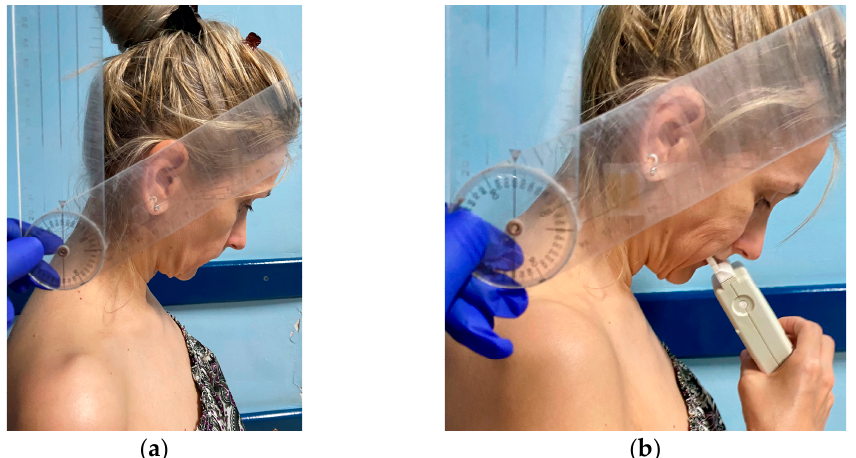
Figure 2. ( a ) Measurement of the neck flexion angle with a manual goniometer in NHP; ( b ) T-Scan registration in NHP.